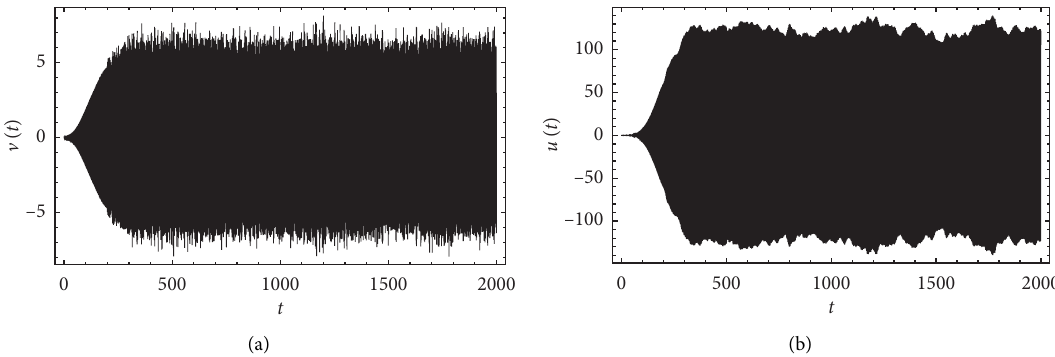
Time history of the controlled system when with the